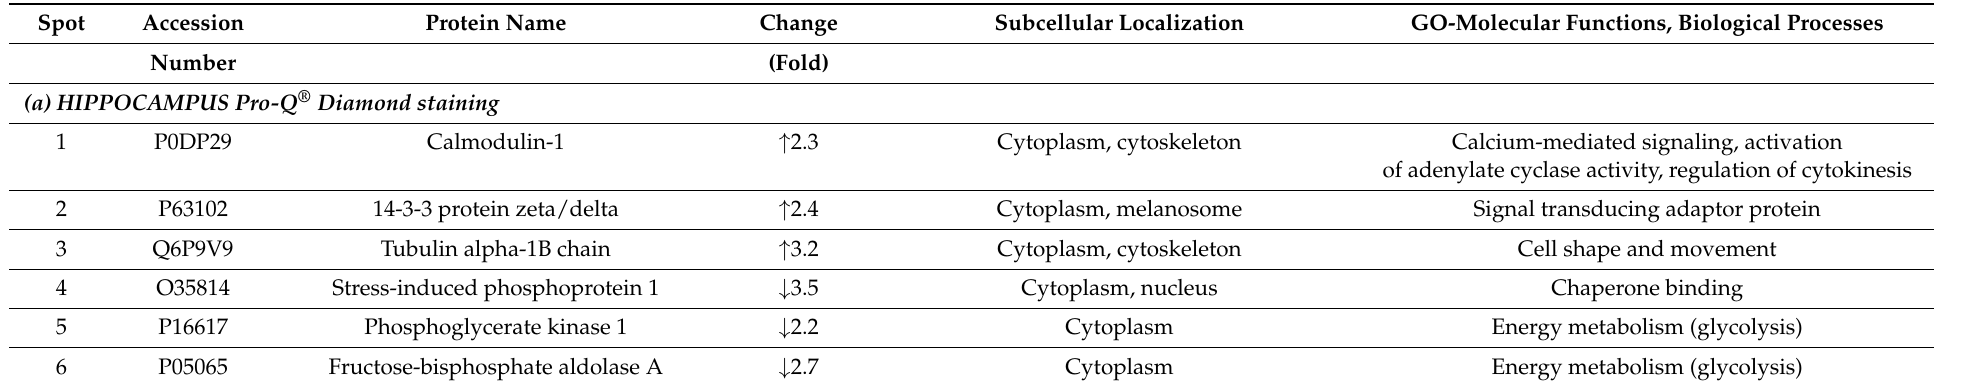
Table 2. Subcellular localization and function of altered proteins identified in the rat hippocampus ( a , b ) and cortex ( c , d ) isolated from animals after 6 months